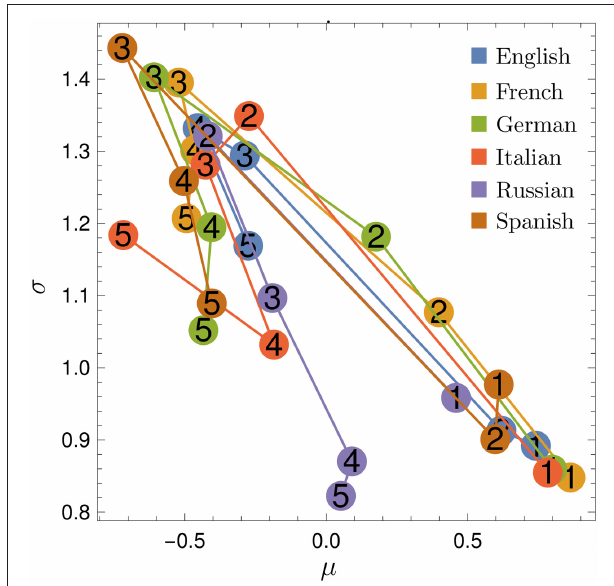
FIGURE 10 | Fitted parameters for rank entropy. Parameters µ and σ for the sigmoid fit of rank entropy E ( k ), for all languages (indicated by colors) and N -values (indicated by